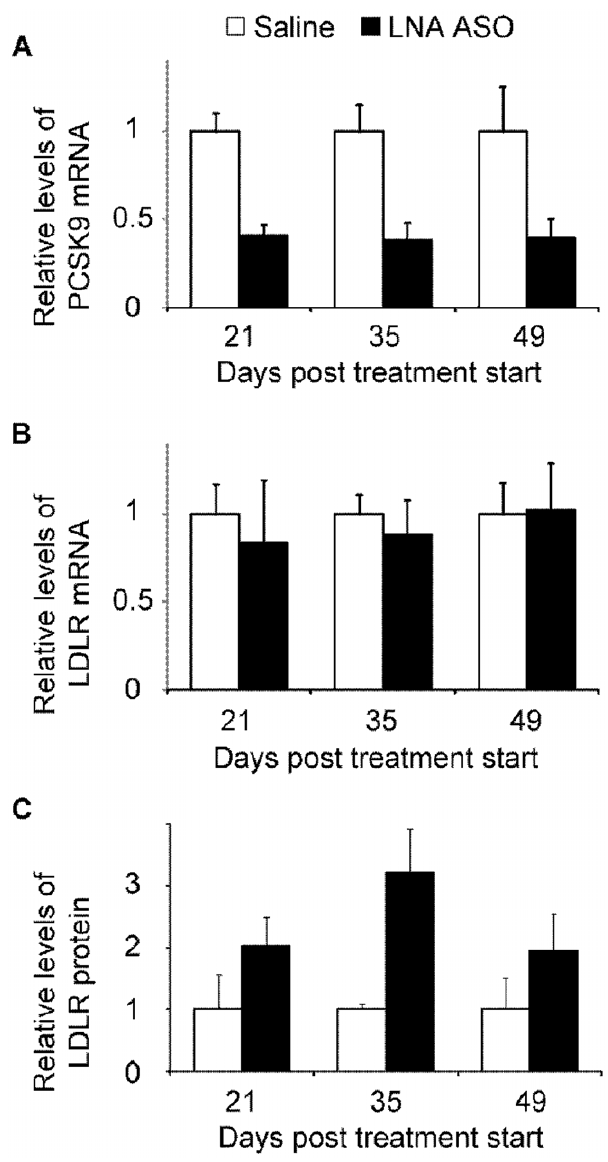
Figure 9. Repeated dosing in mice. Weekly repeated dosing at 5 mg/kg of the LNA ASO led to a stable reduction of PCSK9 mRNA ( A ), unchanged levels of LDLR mRNA ( B ) and 2–3 fold up-regulation of LDLR protein levels ( C ) (white bars: Saline, black bars: LNA ASO) (Mean and SD, n=4–5).